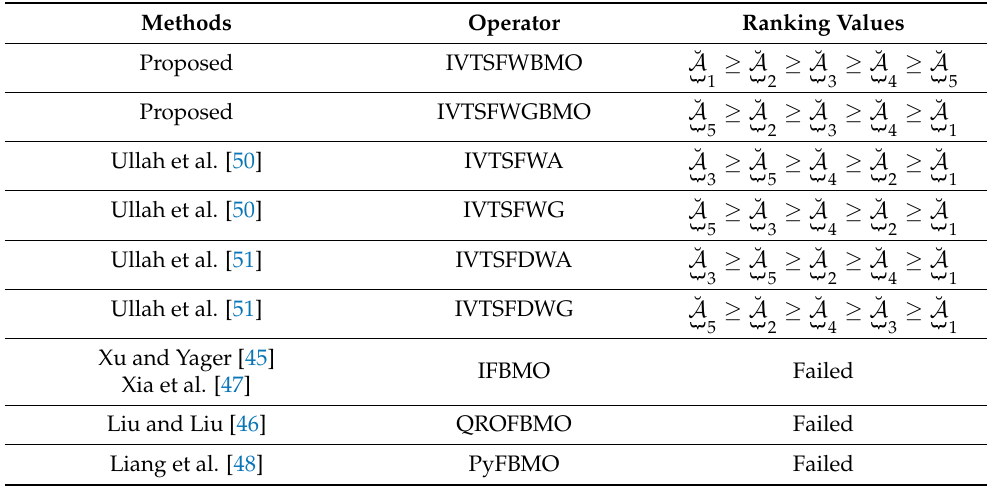
Table 8. Comparative analysis of the proposed and existing operators by using the information in Table 4.